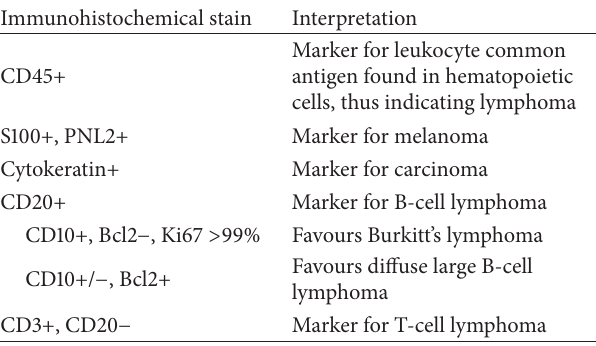
Table 1: Interpretation of immunohistochemical stains in large lymphoid cells lymphomas [11,